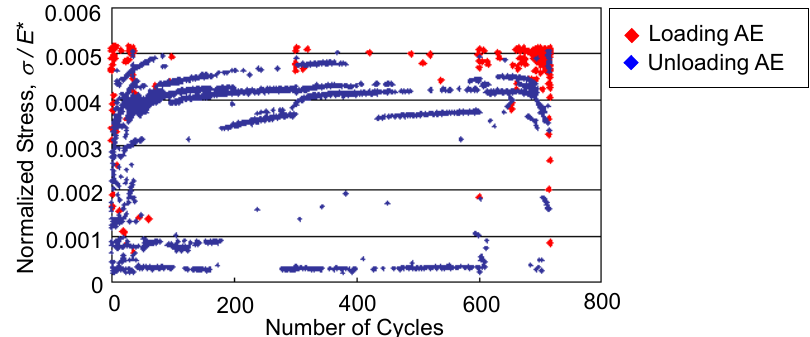
Fig. 8. Distribution of AE events during cyclic compression test. [ σ a / E* =